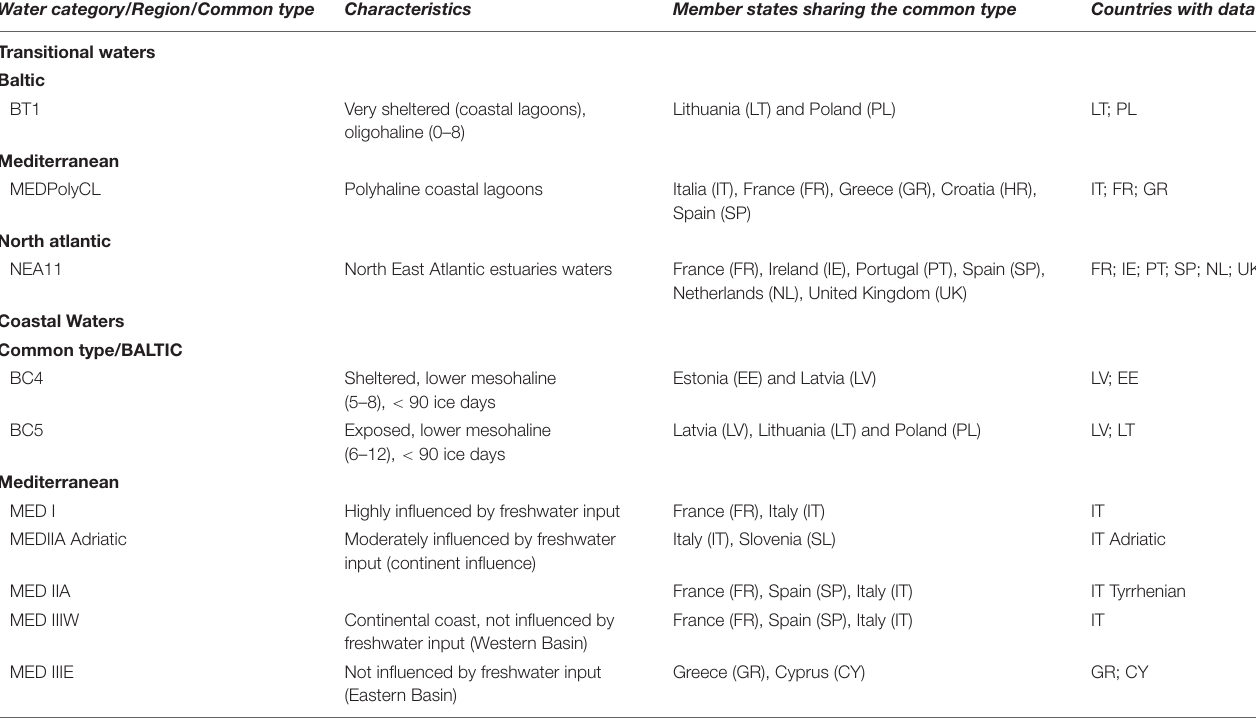
TABLE 1 | Common types and members states (MS) considered for testing the toolkit in this